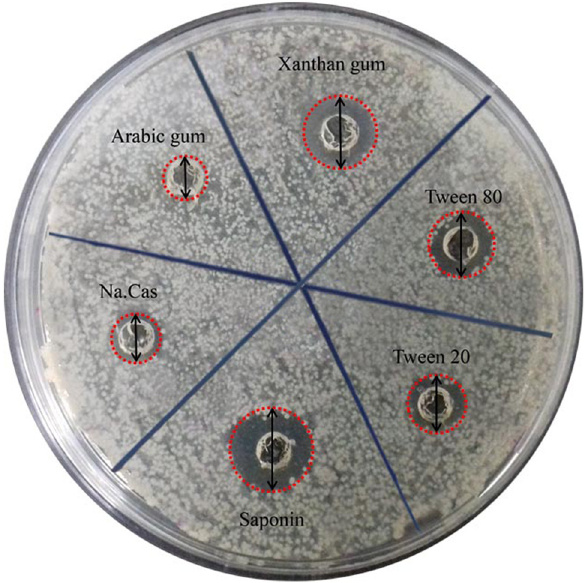
Figure 4: Antibacterial activity of the resulted thyme nanoemulsion using six di ff erent emulsi fi ers against Streptococcus mutans ( incu - bated at 37°C for 24 h )